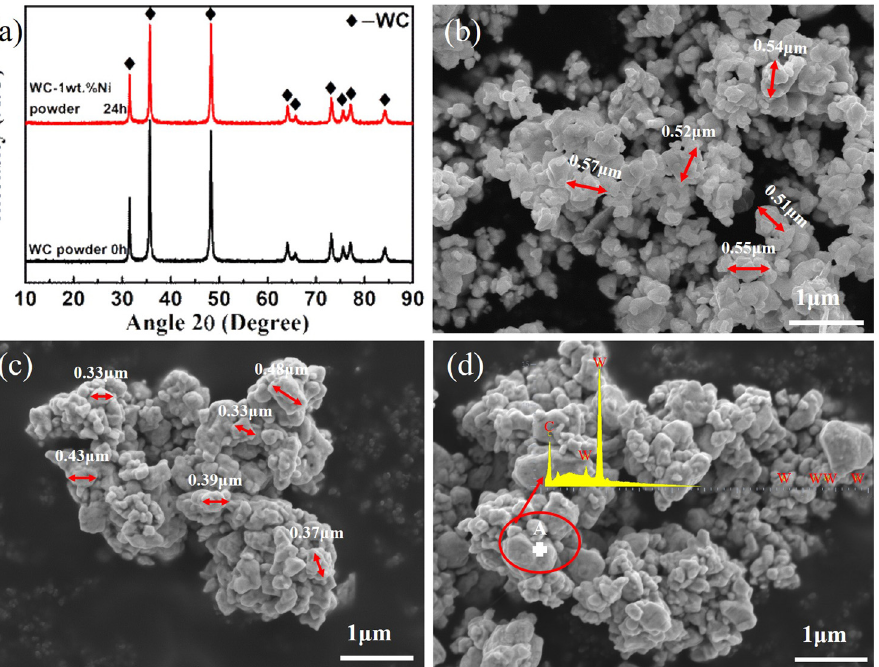
Figure 2: ( a ) XRD patterns of the WC – 1 wt% Ni composite powders ball milled at di ff erent times, ( b ) SEM images of the WC power, ( c ) SEM images of the WC – 1 wt% Ni powder, and ( d ) EDS images of WC – 1 wt% Ni